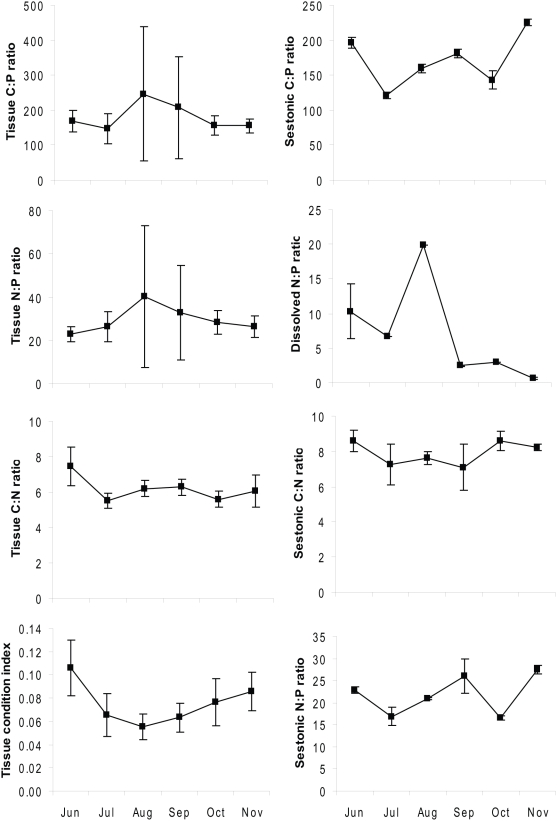
Changes in tissue and sestonic C∶N∶P ratio, dissolved N∶P ratio, and tissue condition index of zebra mussels in Lake Erken over time.Values represent means (±SD).